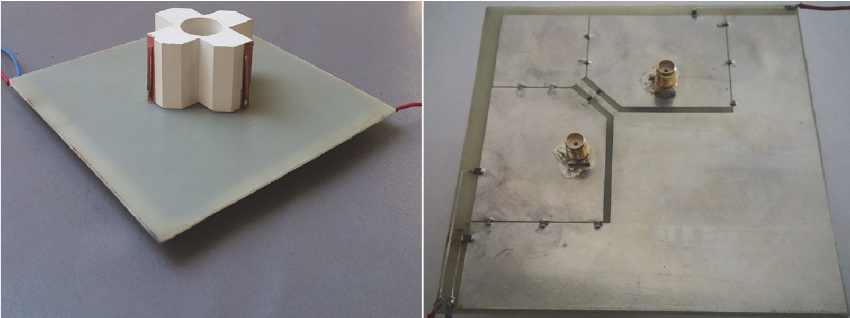
Figure 10: Prototype of the fabricated antenna along with the slots on the ground